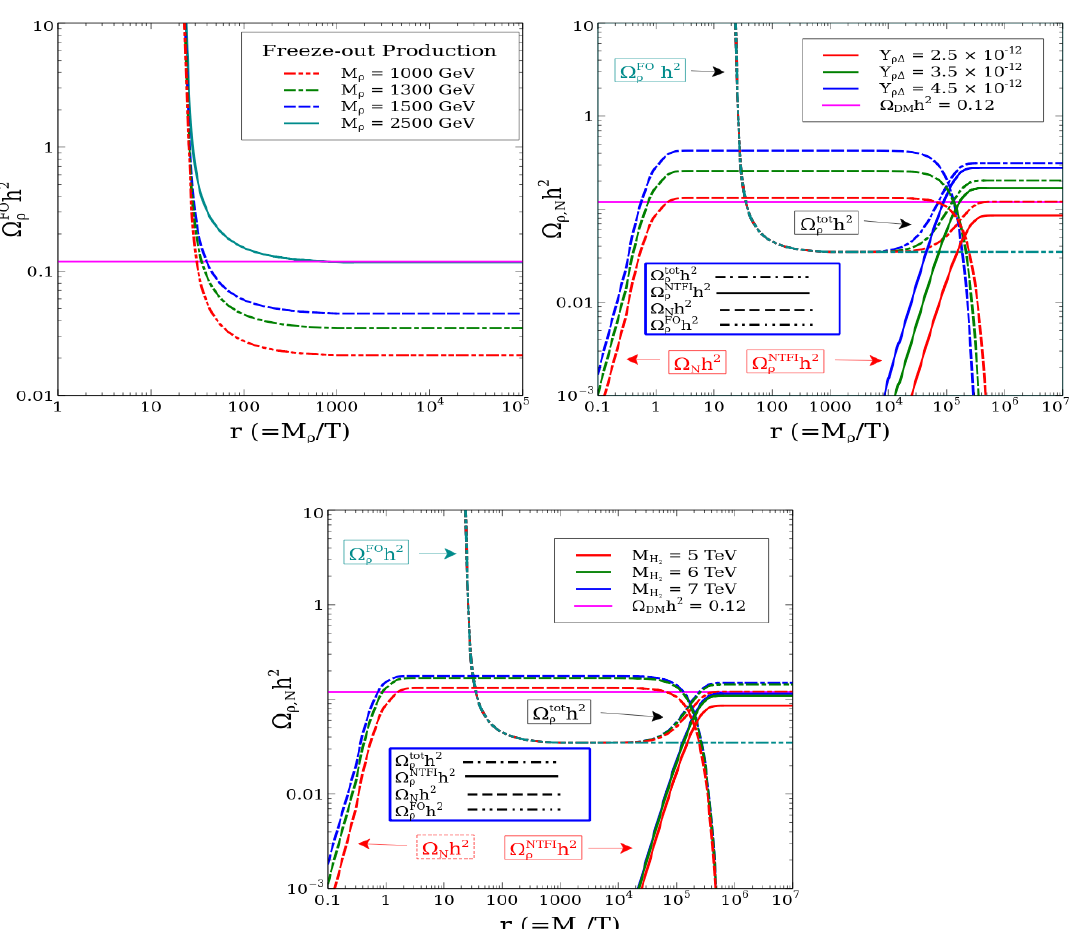
Figure 7 . Top left panel: DM production by only freeze out mechanism for few different values of M ρ . Top right panel: DM production from freeze-out, freeze-in and late decay of N for few different values of Y . Blue dashed dot line is for Y = 4 . 5 × 10 − 12 and the other dashed dot lines with ρ ∆ ρ ∆ different colors are for the descending values of Y . In the same plot, we also show the abundance ρ ∆ of NLOP N denoted as Ω 2 . Lower panel: the same for few different values of heavy Higgs mass N h . In generating the plots we have fixed the model parameters to the following values unless it M H 2 is varied, M = 2000 GeV, M = 1300 GeV, Y = 2 . 5 × 10 − 12 . The magenta line represents the N ρ ρ ∆ reference value of Ω 2 = 0 . 12 . In the plots, Ω tot h 2 is the total contribution represented by the ρ h ρ dashed dot line, Ω NTFI h 2 is the freeze-in contribution when the decaying particle is non-thermal ρ represented by solid line, Ω 2 is the density of N represented by dashed line and Ω FO N h freeze-out contribution represented by dashed dot dot